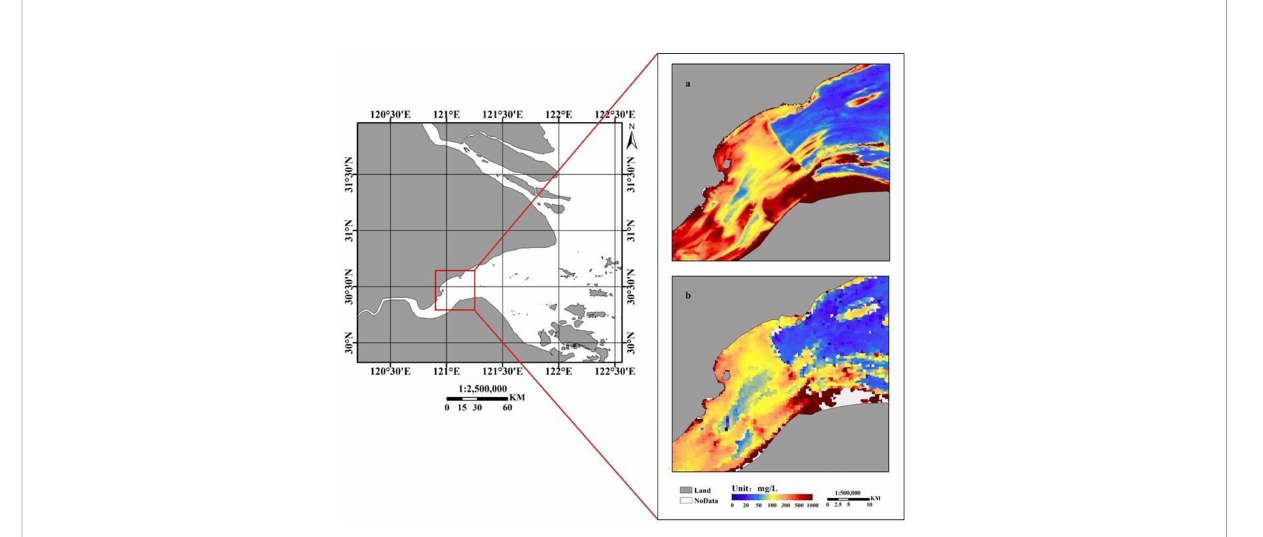
FIGURE 8 Comparison of partial SSC retrieval results of the study area based on OLCI (A) and GOCI (B) data.